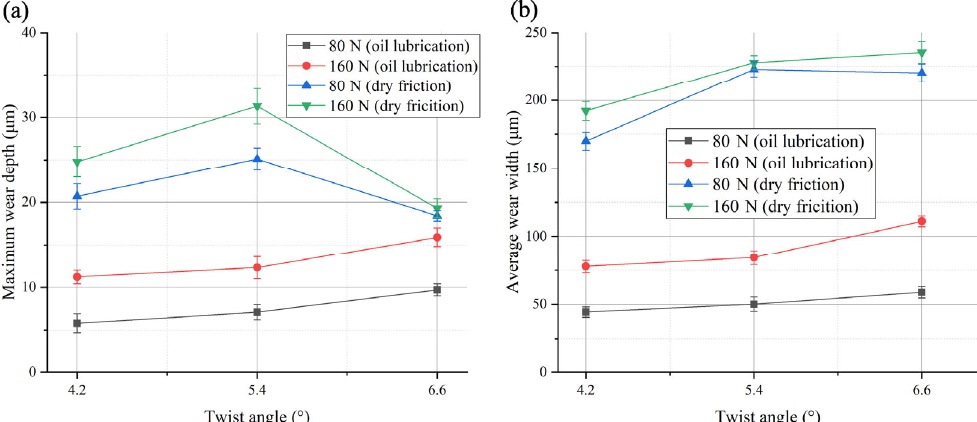
Fig. 20 Maximum wear depths and average wear widths of different lateral loads and twisting angles under different lubrication. (a) Maximum wear depths, (b) average wear